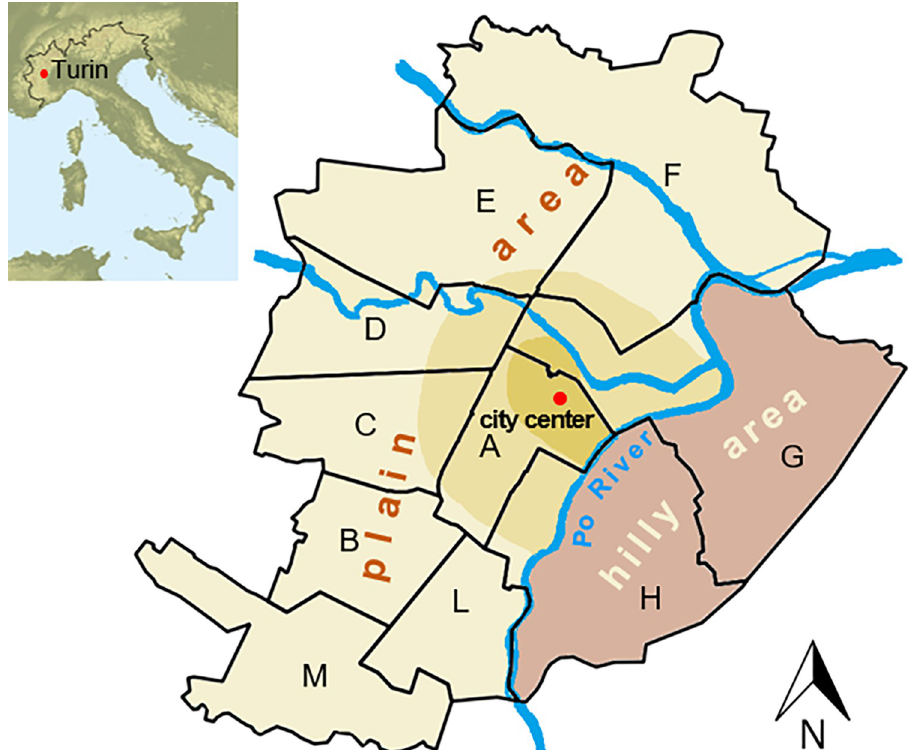
Fig 3. The city of Turin and its administrative